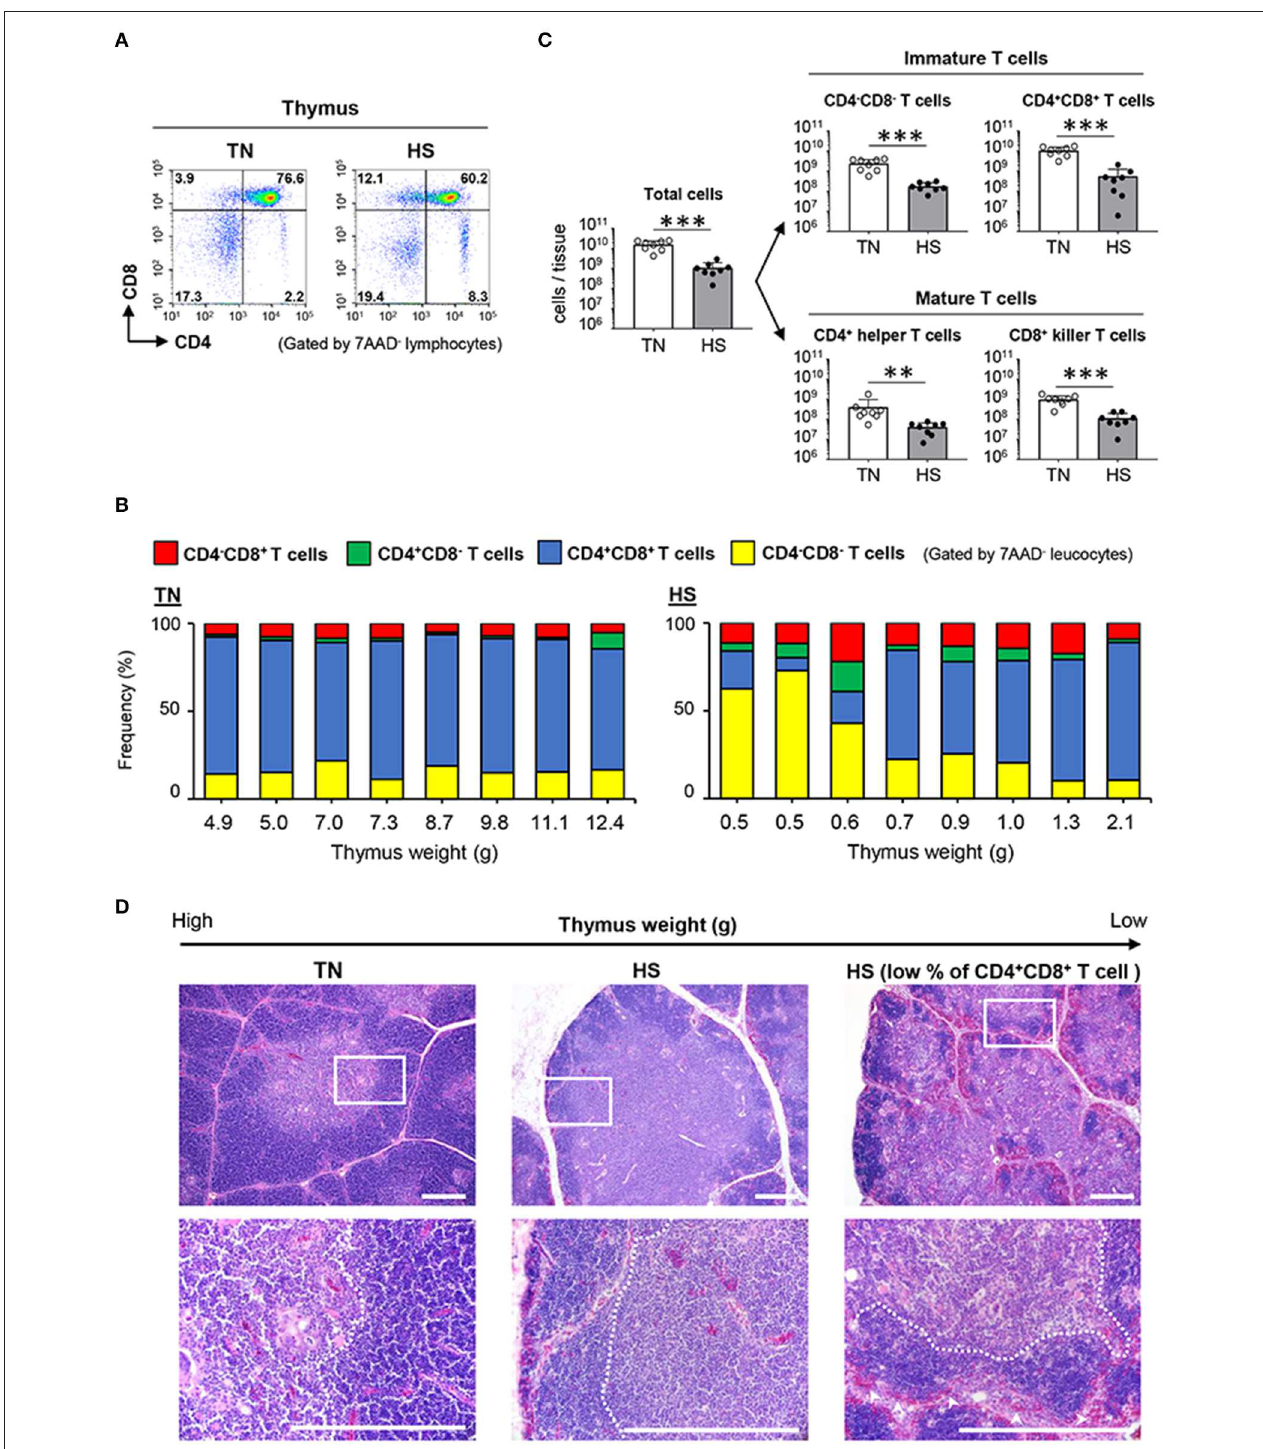
FIGURE 5 | Effect of HS on the immature and mature T cells of the thymus. Broiler chickens were maintained in either TN or HS condition for 14 days (A,B) . Representative flow cytometry profiles of 7AAD − leucocytes in the thymus at 36 days of age. (C) Cell components of thymic lymphocytes including CD4 − CD8 − cells, CD4 + CD8 + cells, CD4 + CD8 − helper T cells, and CD4 − CD8 + killer T cells, and absolute number of thymic T cell subsets were analyzed by flow cytometry. (D) Representative hematoxylin and eosin-stained histological sections of the thymus at 36 days of age. Scale bar: 200 µ m. Dotted line: Border between cortex and medulla. Arrowheads: erythrocytes. The data are presented as means ± SE ( n = 8/group). ** p < 0.01, *** p < 0.001 compared with the TN group (unpaired two-tailed Student’s t- test).